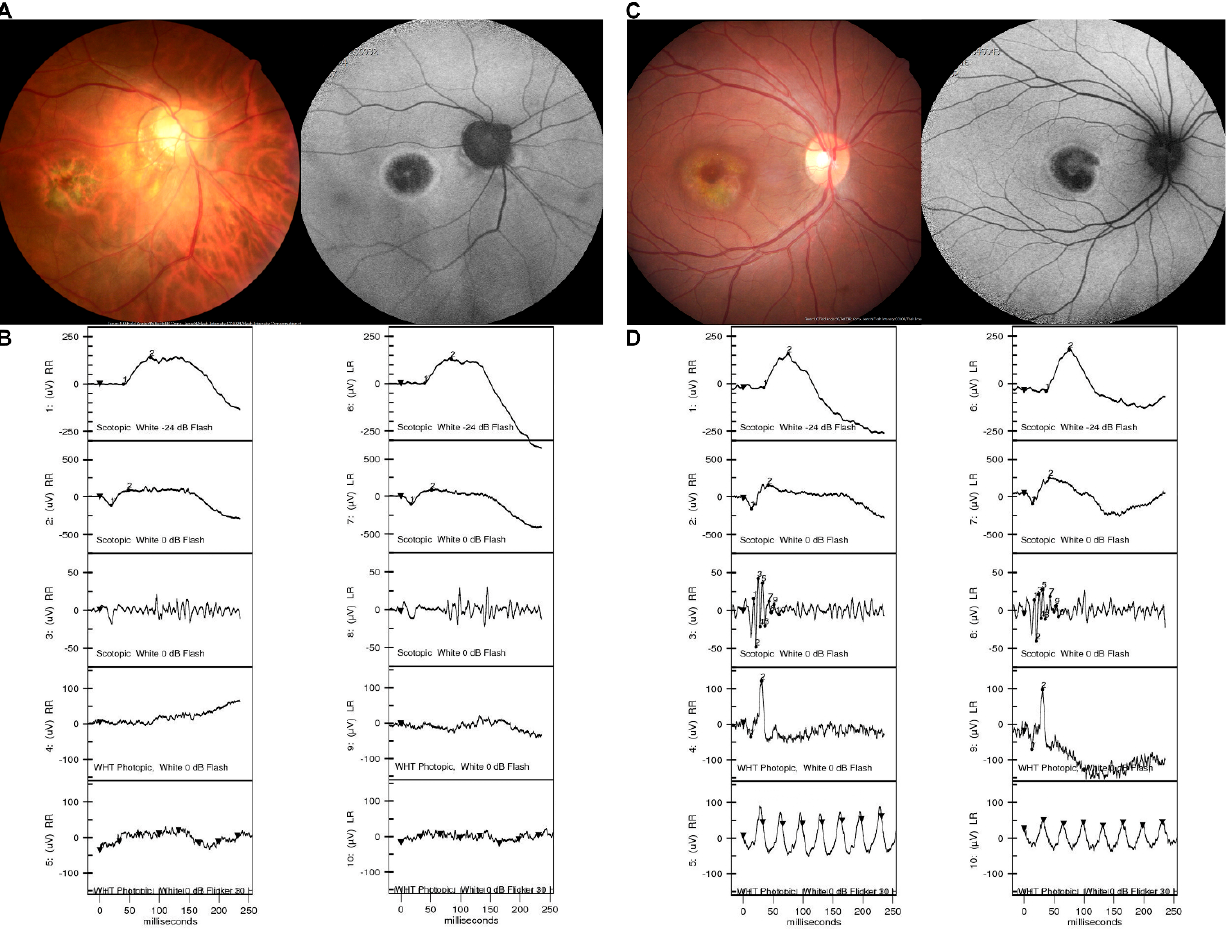
Figure 4. Representative cases illustrating the diagnostic value of ffERG in differentiating cone dystrophy and macular dystrophy. ( A ) Color fundus image and fundus autofluorescence in a 42-year-old male patient eventually diagnosed with cone dystrophy, presenting with central hypo-autofluorescence surrounded by a hyper-autofluorescent ring, resembling bull’s eye maculopathy. ( B ) ffERG in the same patient demonstrated abnormal light-adapted 3.0 and light-adapted 3.0 30 Hz series, which confirmed the diagnosis of cone dystrophy. ( C ) Color fundus image and fundus autofluorescence in a 21-year-old female patient eventually diagnosed with macular dystrophy, presenting with similar patterns as bull’s eye maculopathy. These images were not helpful for differentiation from the previous patient. ( D ) ffERG in this patient demonstrated normal cone and rod responses, indicating a diagnosis of macular dystrophy, which could be clearly differentiated from cone dystrophy using ffERG.